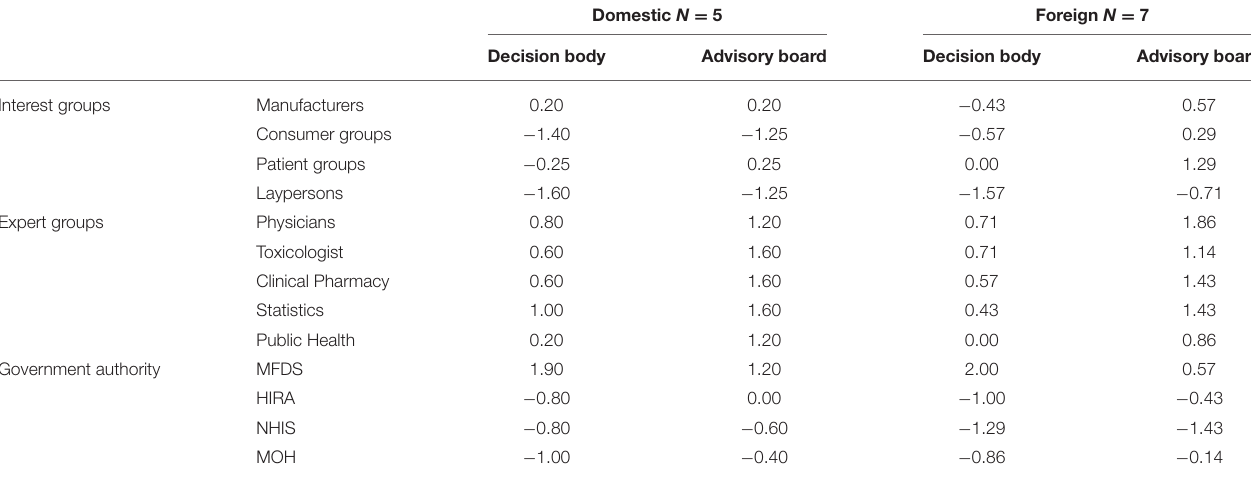
TABLE 2 | Relevance of the participation of various stakeholders in a decision-making body and advisory board.